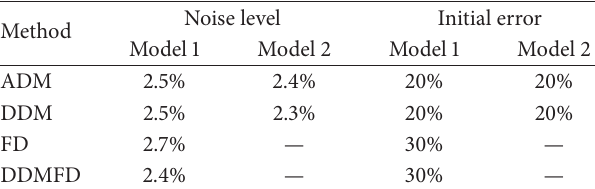
Table 13: Stability of different methods against noise and initial